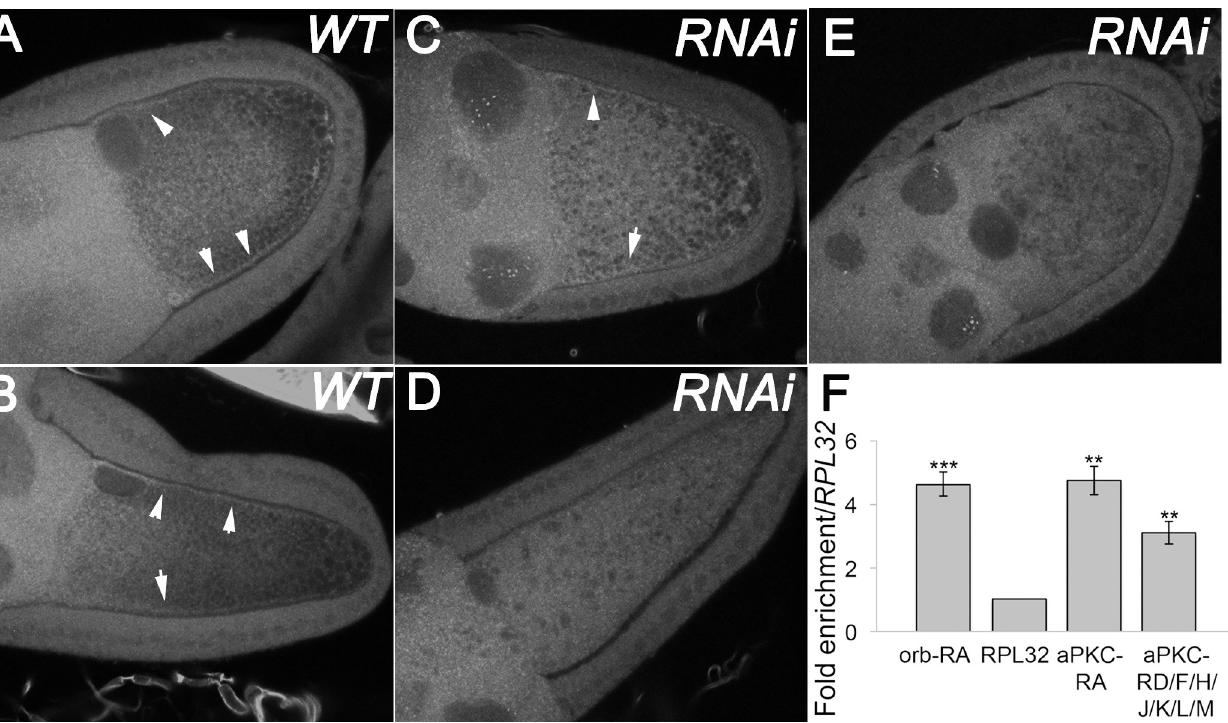
Fig 5. aPKC mRNA localization depends on orb and Orb binds to aPKC 3’UTRs. (A and B) In wild type egg chambers aPKC mRNA is localized along the anterior lateral cortex of the oocyte (arrowheads). (B) When orb RNAi ( 64002 ) is driven by a midstage driver, maternal α -tubulin Gal4 (7062) , aPKC mRNA localization is patchy along the oocyte cortex (arrowheads), or is not localized along the cortex (D and E). (F) Orb immunoprecipitation followed by RT- qPCR shows enrichment of orb-RA 3’UTR and multiple species of aPKC 3’UTRs. The enrichment is calculated using ΔΔ CT, and orb and aPKC 3’UTRs are significantly enriched compared to the control 3’UTR, RPL32 (n = 3 biological